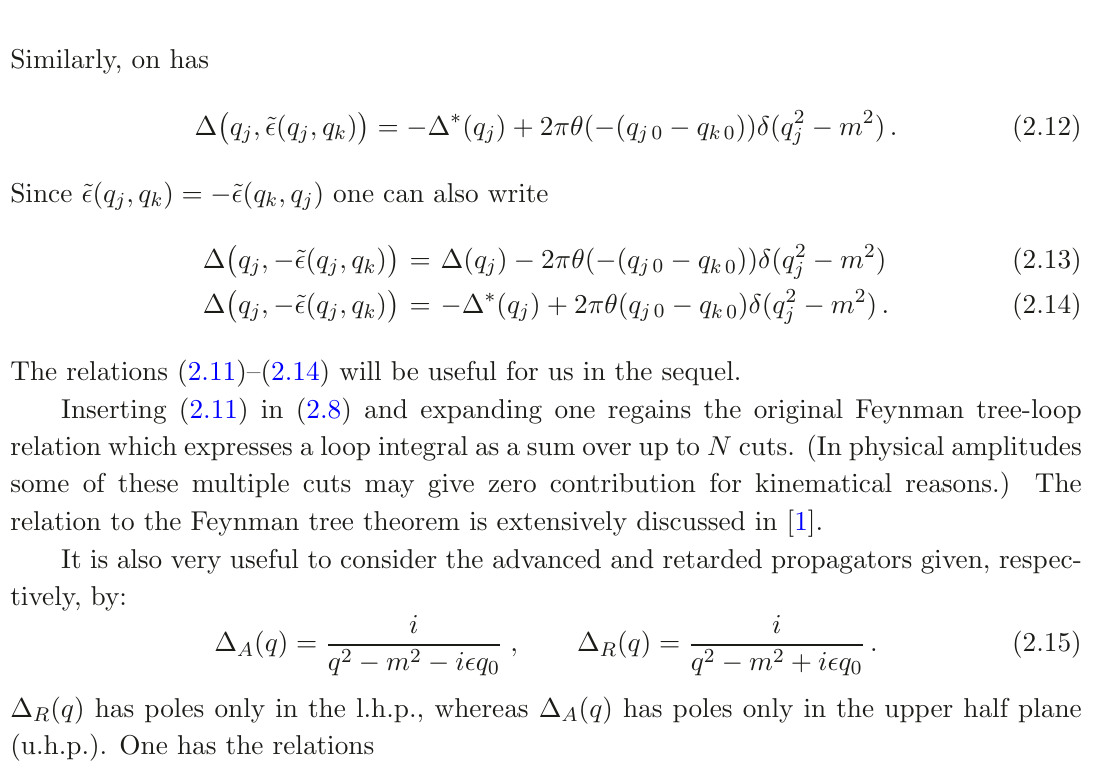
Figure 2 . Graphical depiction of Cutkosky cuts: (a) positive; (b) negative. Energy flows form the unshaded to the shaded